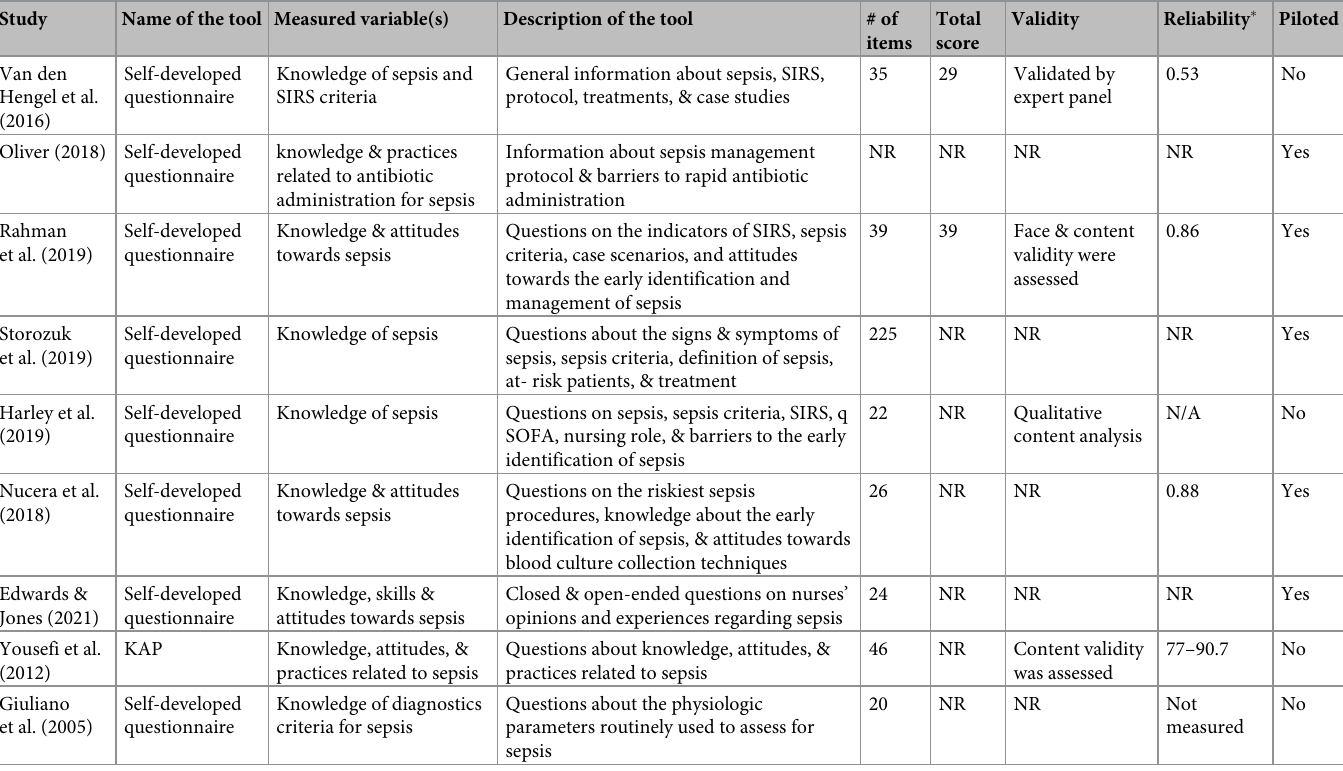
Table 5. A summary of the measurement tools and their psychometric